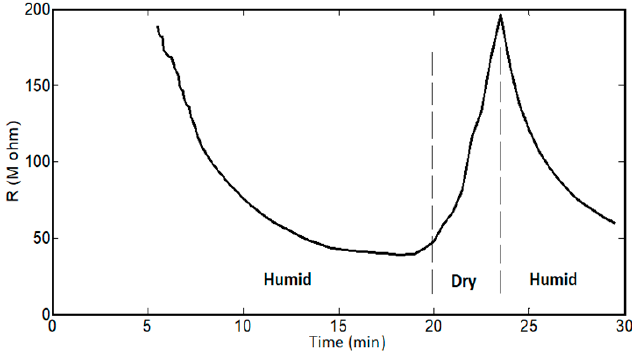
Figure 13. Decay of electric resistivity of spider silk nanofibers versus time in a fully humid environment.